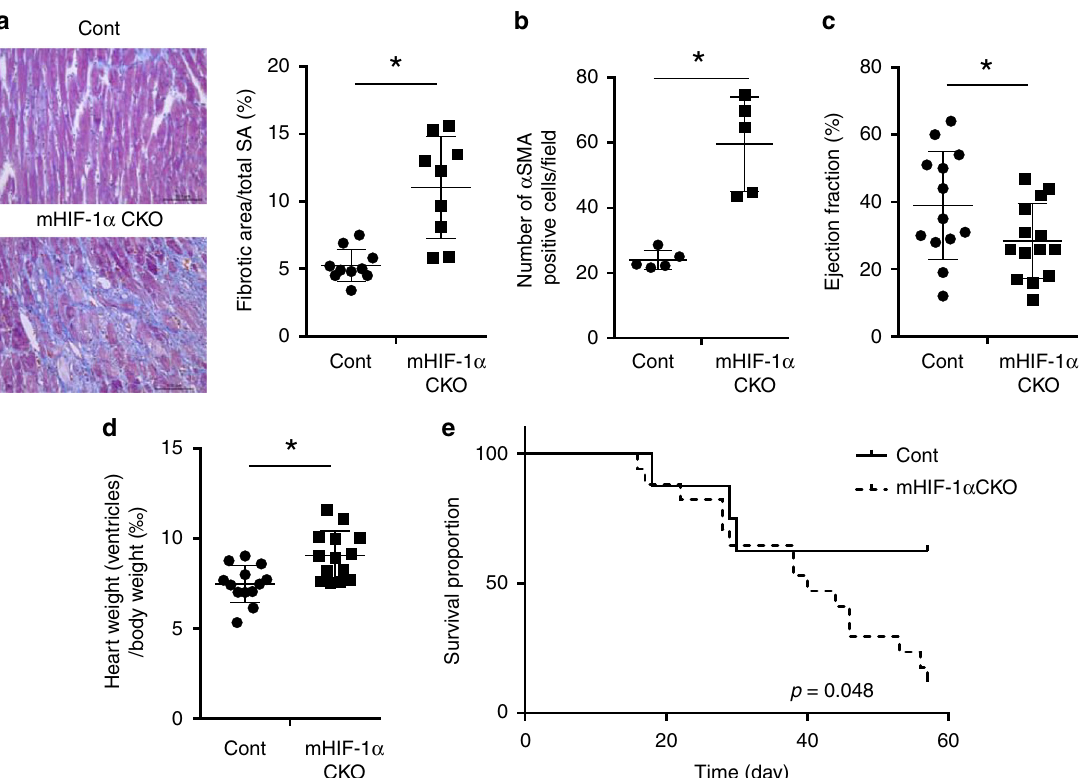
Fig. 2 Cardiac fi brosis develops in myeloid-speci fi c HIF-1 α conditional knockout mice. a Masson ’ s trichrome staining was performed using cardiac tissue of myeloid-speci fi c HIF-1 α conditional knockout mice ( mHIF-1 α CKO: HIF-1 α fl ox/ fl ox ; LysM-cre + / − ) 14 days after TAC operation. Cre negative littermates were used as a control (cont). Fibrotic area was calculated compared to the total surface area (SA). Cont ( n = 10) and mHIF-1 α CKO ( n = 9). Scale bar = 100 μ m. b The average number of α -smooth muscle actin ( α SMA) positive cells 14 days after TAC operation were counted within fi ve fi elds. Cont ( n = 5) and mHIF-1 α CKO ( n = 5). c Data represent the ejection fraction 28 days after TAC operation in cont ( n = 13) and mHIF-1 α CKO mice ( n = 14). d Data represent the heart weight (ventricles) per body weight ( ‰ ) 28 days after TAC operation in cont ( n = 13) and mHIF-1 α CKO mice ( n = 14). The Mann – Whitney U test was used to compare differences between mHIF- α CKO and cont ( a , b , c , d ). e The Kaplan – Meier survival curves for control mice ( n = 8) and mHIF-1 α CKO mice ( n = 17). The log rank test was used for the statistical analysis. Error bar represents the standard deviation. * p <